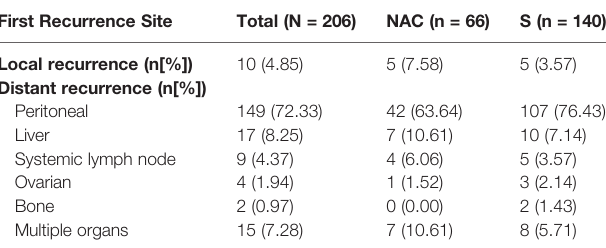
TABLE 3 | Details of fi rst recurrence